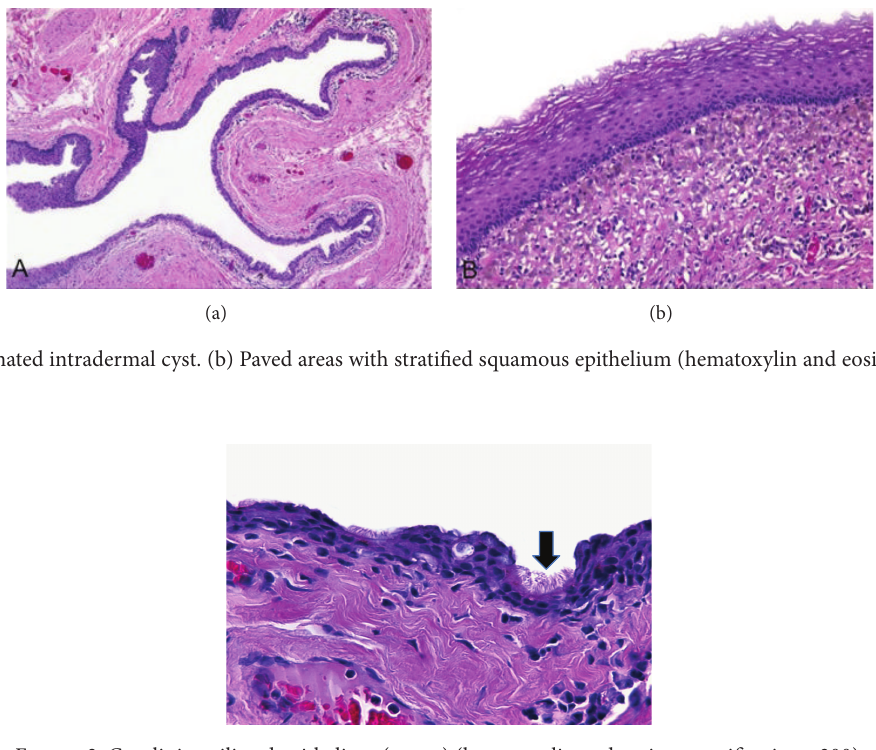
Figure 2: Cyst lining ciliated epithelium (arrow) (hematoxylin and eosin, magnification × 200).